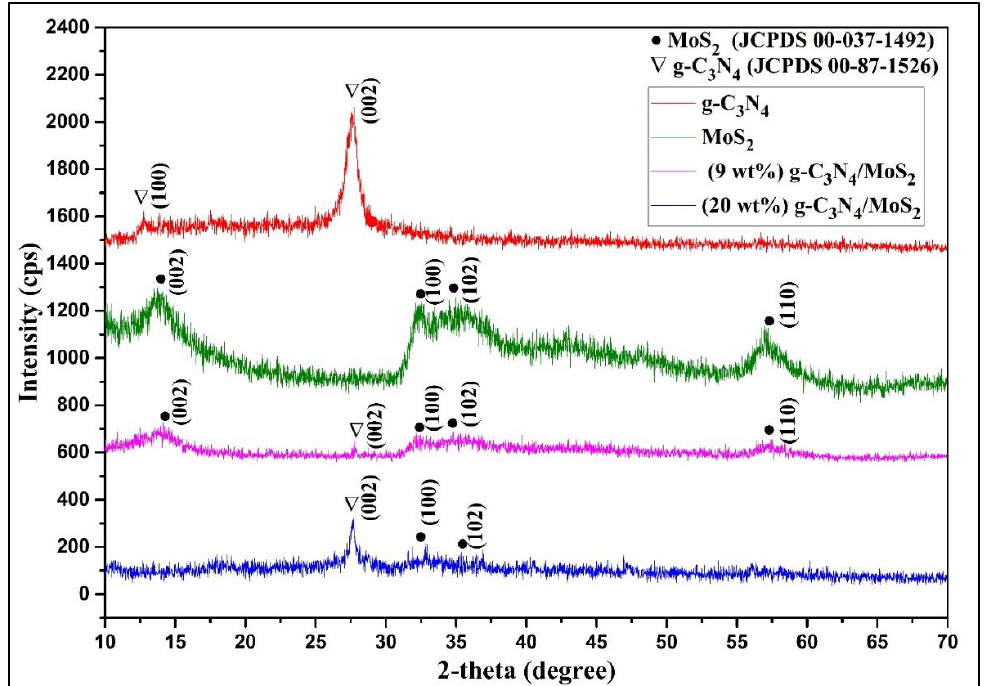
Figure 4. XRD pattern of MoS 2 , g-C 3 N 4 and their composites.